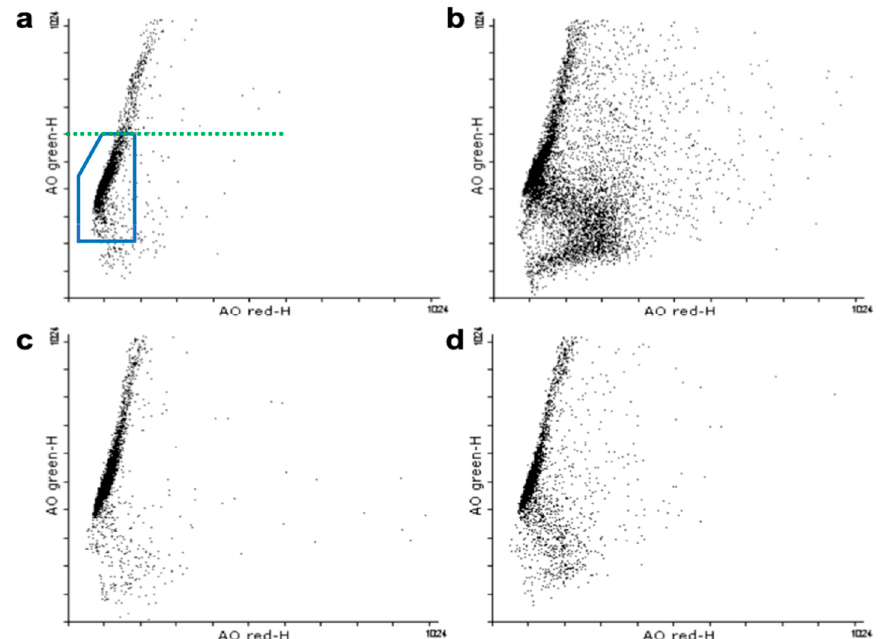
Figure A1. Results of the flowcytometric measurements (SCSA). Detection of green fluorescence is shown on the y -axis, detection of red fluorescence on the x -axis. The main sperm population is marked blue in ( a ), sperm outside this region on the right exhibit elevated amounts of DNA fragmentation. High DNA stainability can be found above the green line shown in ( a ). ( a , b ) represent CP/CPPS patient samples, ( c , d ) samples of the control group. ( a ): CP/CPPS with very low amounts of sperm with DNA fragmentation. ( b ): CP/CPPS with high amounts of sperm with DNA fragmentation. ( c ): control with very low amounts of sperm with DNA fragmentation. ( d ): control with high amounts of sperm with DNA fragmentation.